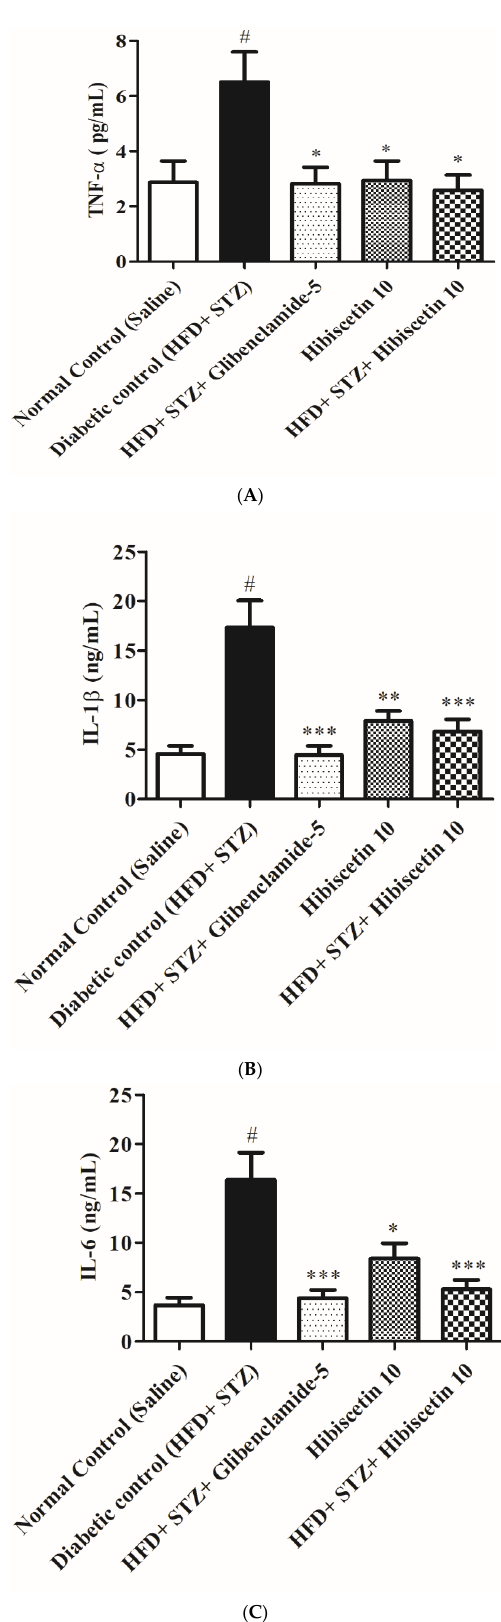
Figure 5. ( A – C ) Effect of hibiscetin on proinflammatory cytokines (n = 6). The mean SEM is used to express the data; ( # p < 0.05) saline vs. HFD+STZ, (*** p < 0.001, ** p < 0.01, and * p < 0.05) HFD+STZ vs. treatment group.